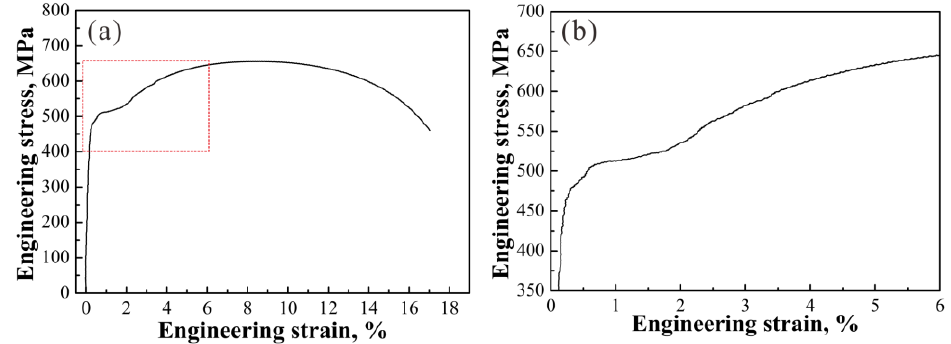
Figure 7. ( a ) Tensile engineering stress-strain curve and ( b ) magnified yielding zone of the specimen after inter-critical holding at 755 °C for 300 s and quenching.